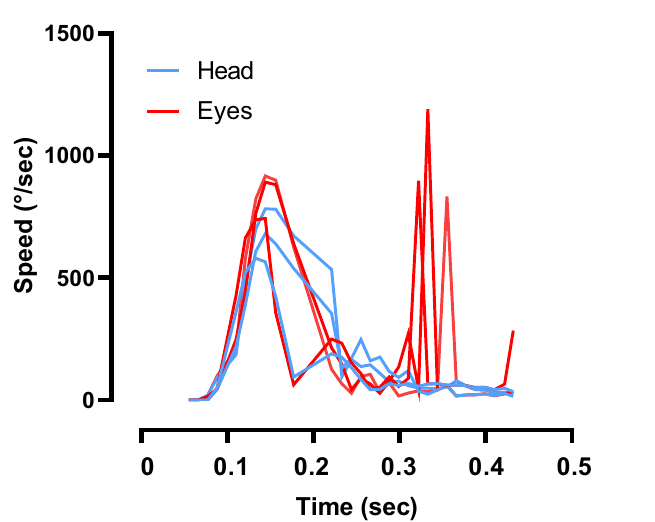
Figure 5. The control interface. The interface allows the trainer to change the parameters related to the head- impulse test scenario and to supervise the video feed from the virtual examination room and the patient’s right eye. It also allows to record the mannequins eye and head positions during the exercises.